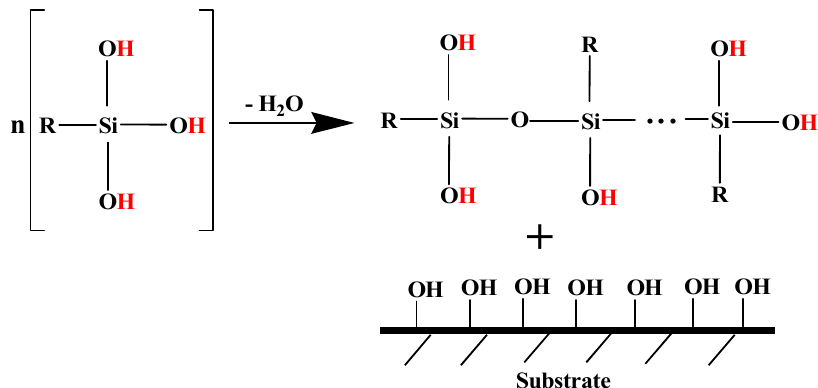
Figure 2. Representation of the general hydrolysis mechanism of silanes. Adapted from [30].